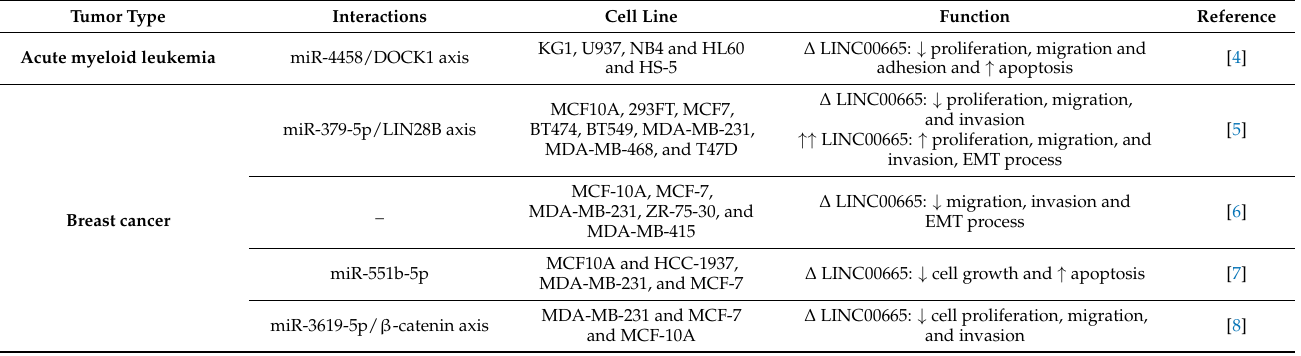
Figure 1. Demonstrates the oncogenic role of LINC00665 in prostate cancer, colorectal cancer, breast cancer and osteosarcoma. Table 1. LINC00665 expression in cell lines ( ∆ : knock-down or deletion, CRC: colorectal cancer, DDP: cisplatin, AML: acute myeloid leukemia).